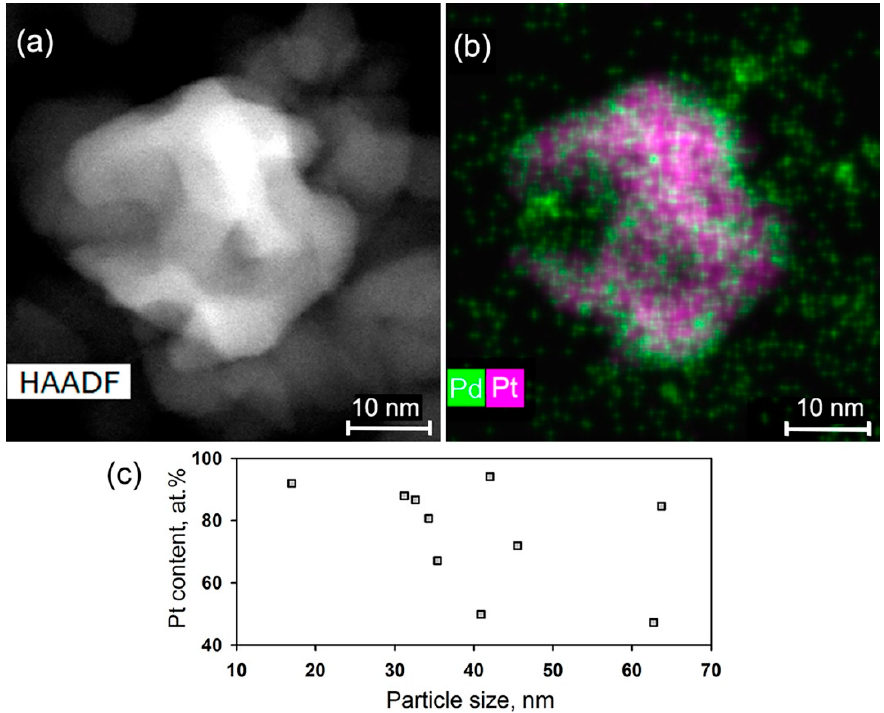
Figure 7. HAADF-STEM image: ( a ) EDX-STEM map ( b ) of the SnO 2 /PtPd nanocomposite. ( c ) Pt content in PtPd nanoparticles of different size.